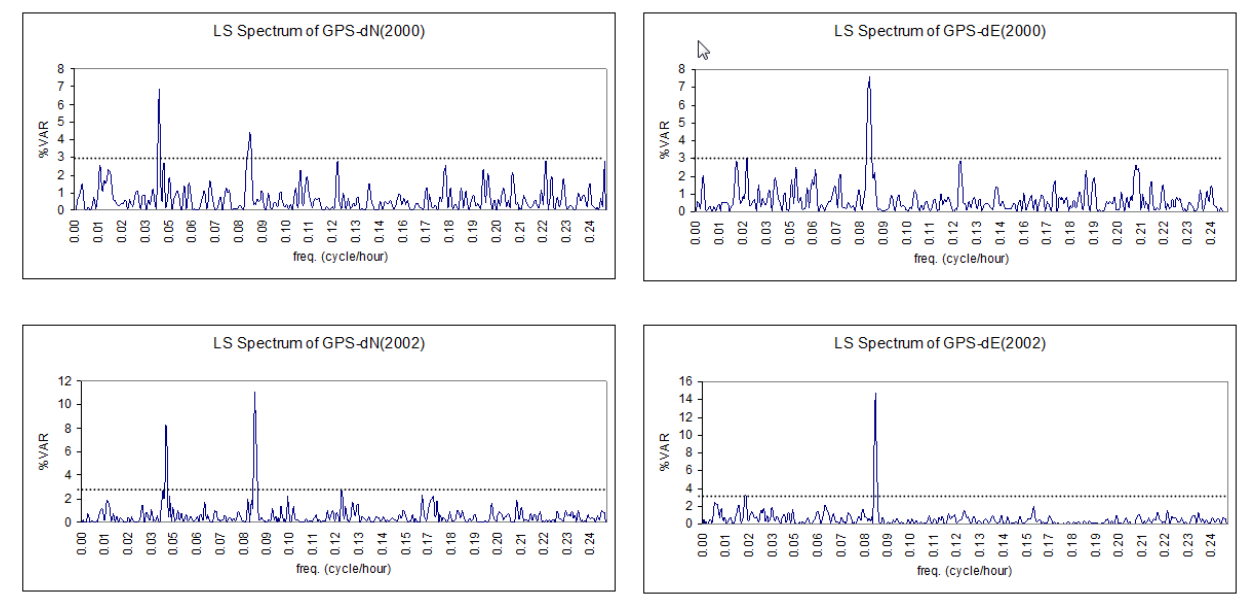
Figure 14. LS spectrum of GPS data (time series of the northing (dN) and easting (dE) components of the ISTA pillar position ) for both campaigns in 2000 and